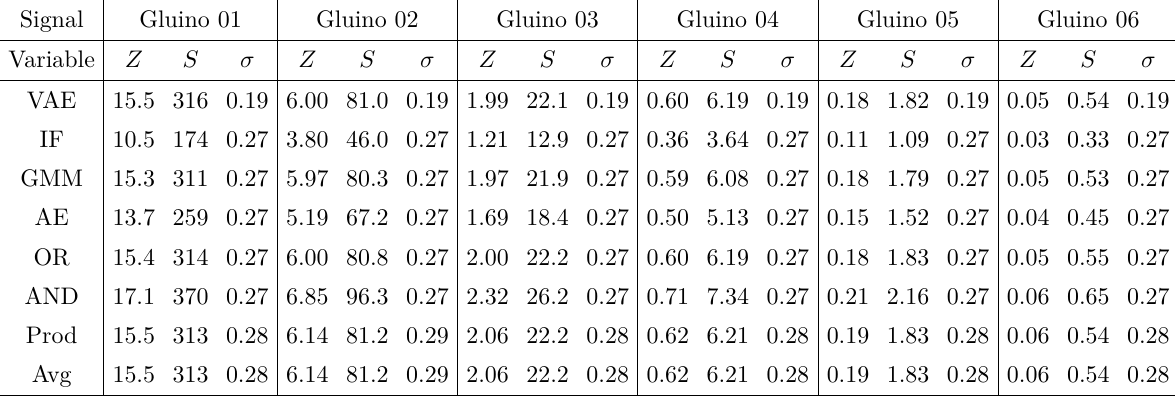
Table 4 . Table for algorithms applied on latent space representations. It shows Z -scores for the gluino signals taken at 100 background events with no systematic uncertainty applied, the number of signal events ( S ) at said background cut, and the uncertainty on the background cut ( σ